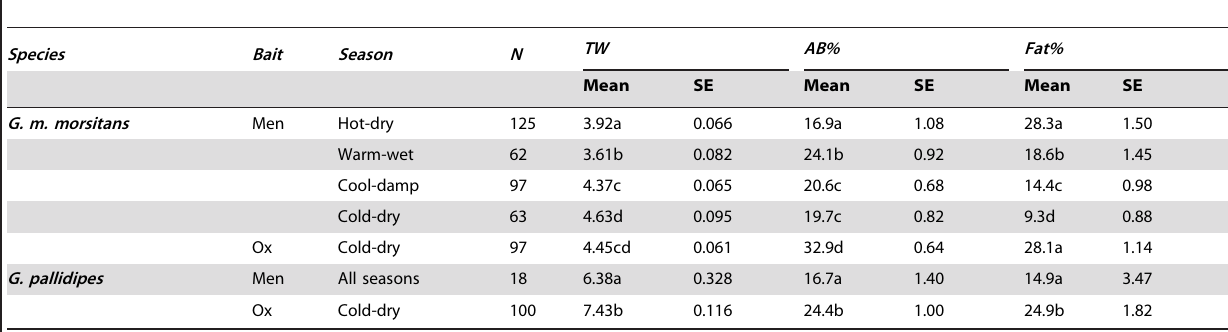
Table 7. Nutritional status of male tsetse caught from men or oxen at various seasons.